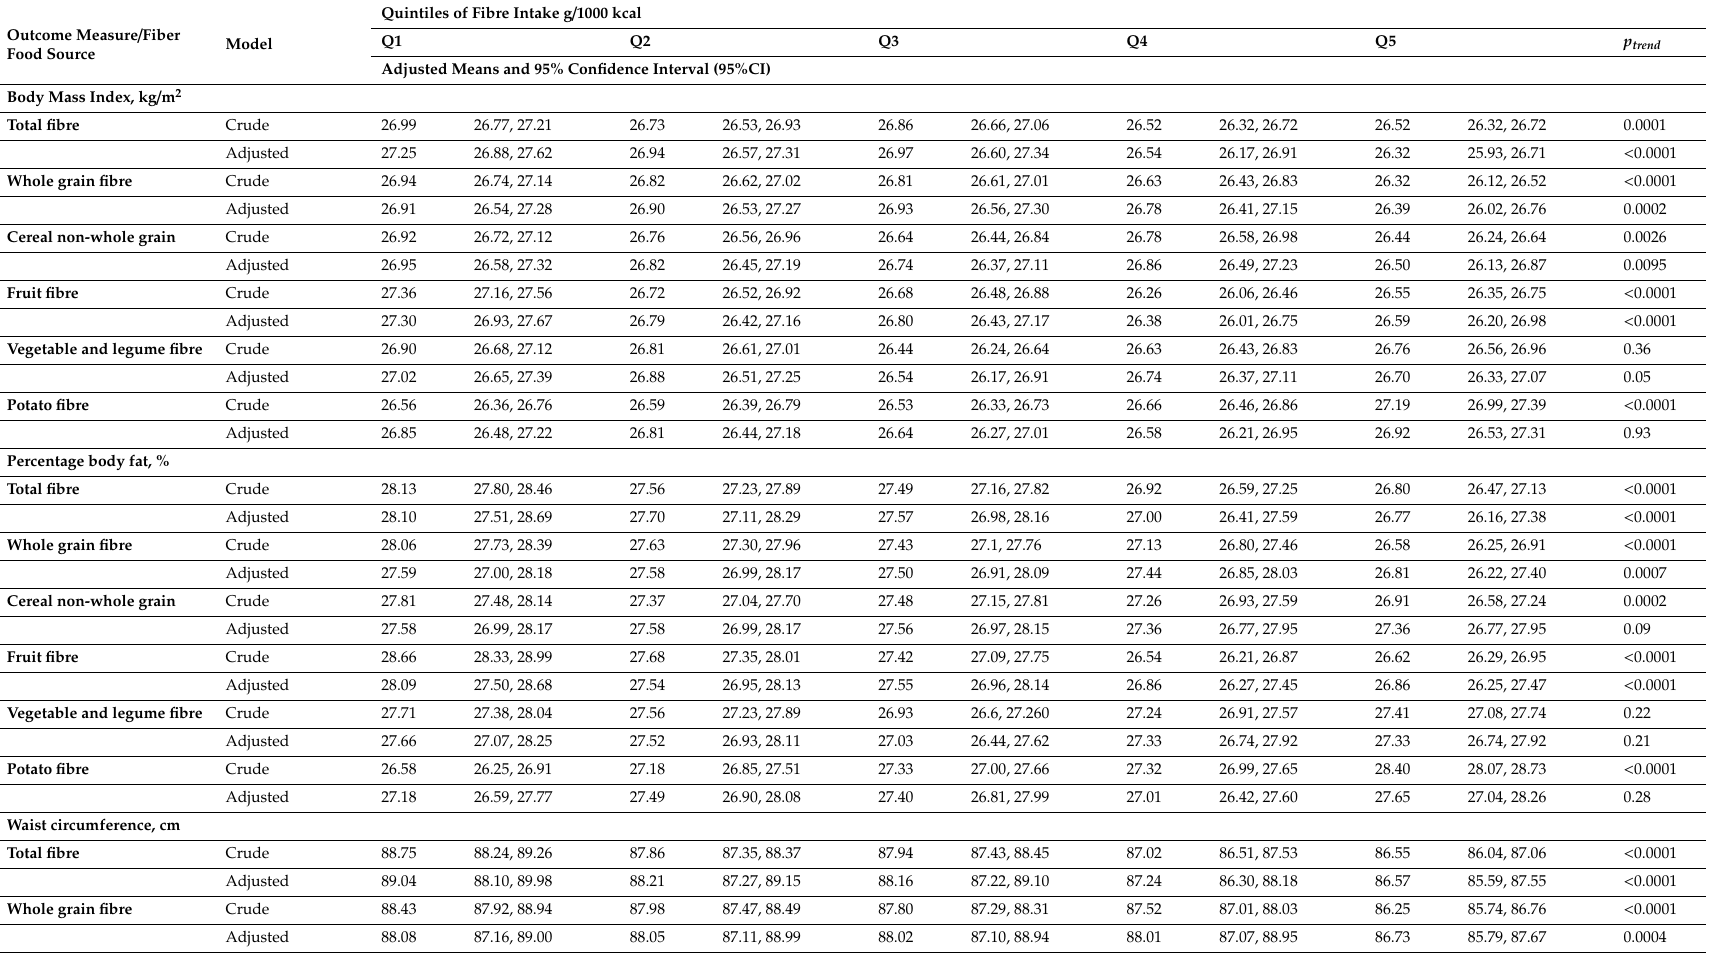
Table 3. Estimated mean body mass index, body fat percentage, waist circumference and C-reactive protein by quintile of energy-adjusted total fiber intake (g / 1000 kcal) of Airwave Health Monitoring Study participants ( n = 6898) 1